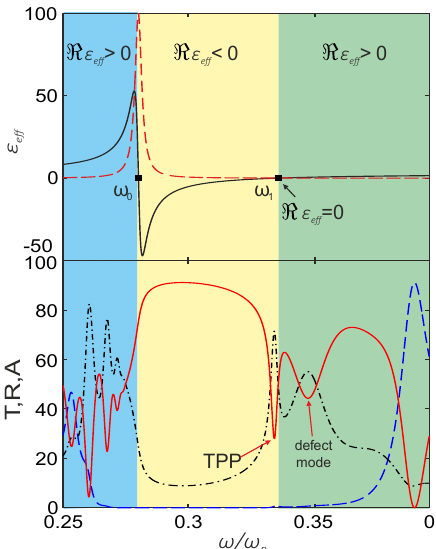
Figure 2. Dependences of the imaginary (cid:61) ε eff ( ω ) (dashed red line) and real (cid:60) ε eff ( ω ) (solid black line) parts of the effective permittivity ε eff ( ω ) on normalized frequency ω / ω p (on the top) and transmittance (dashed blue line), reflectance (solid red line) and absorbance (dash-and-dot black line) spectra of the PhC/nanocomposite structure at the normal incidence of light onto it (Figure 1). The nanocomposite layer thickness is d eff = 300 nm and f = 0.11.